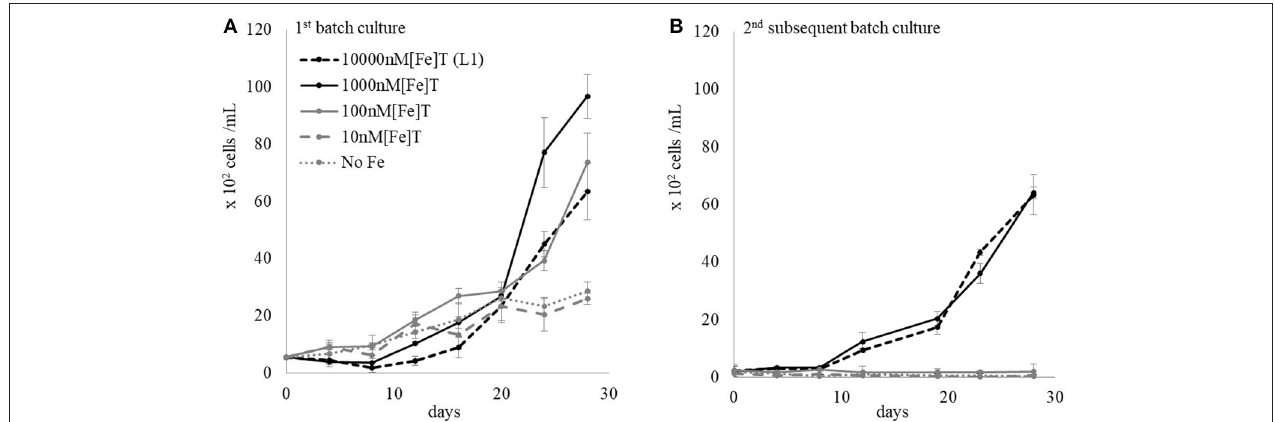
FIGURE 2 | L. polydrum co-cultured with a starting inoculum of DG893 at 10 3 cells/mL in media with various [Fe] T. (A) First generation growth of L. polyedrum in the presence of DG893. The starting inoculum of DG893 was 10 3 cells/mL which reached 10 5 cells/mL after 28 days incubation under the standard growth conditions. A similar pattern was observed in all other groups: i.e., media containing a starting inoculum of DG893 of 10 7 , 10 6 , 10 5 , 10 4 , 10 3 , 0 cells/mL and [Fe] T of 10 4 , 10 3 , 10 2 , 10 1 , or 0nM. (B) Second generation growth of L. polyedrum in the presence of DG893. After 28 days the cultures in (A) were diluted to a L. polyedrum concentration of 10 2 cells/mL with appropriate media and incubated under the standard growth condition for an additional 28 days.